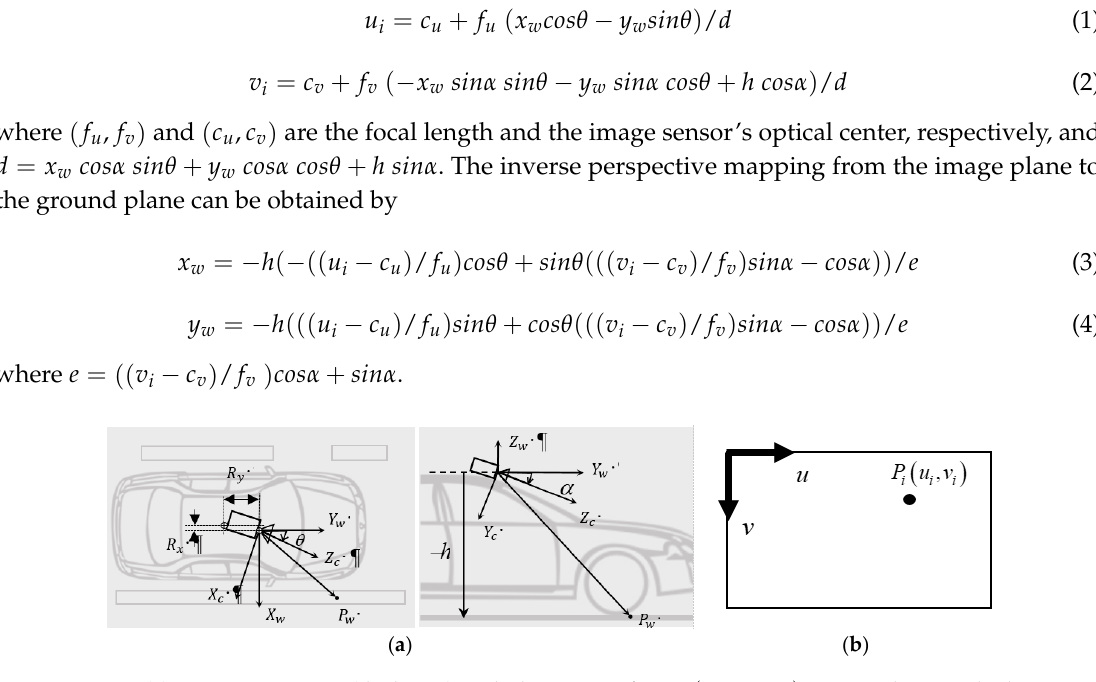
(cid:0) (cid:1) R x , R y from the vehicle center